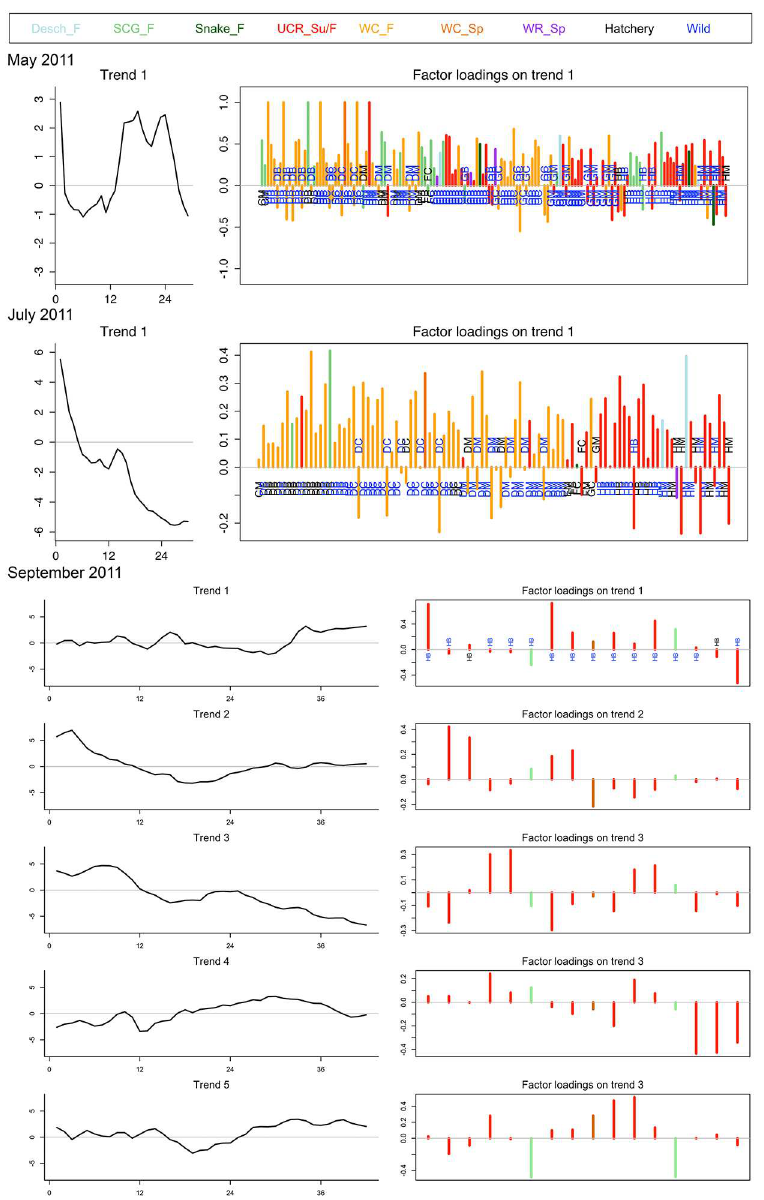
Fig 4. DFA trends(left)and trendloadings(right)for each monthlycapturegroup in 2011. The trends are reported as z-scoredgrowth rates (y-axis)over weeks (x-axis)startingat estimatedemergence and endingat capturein the estuary. The trendloadings show each individualfish’s relationshipto that trend(e.g. positive or negative) by capturelocation(site acronyms listed).The trendloadingsalso denote geneticstock of originfor each individual(barcolor)and hatcheryor wild origin(siteacronym